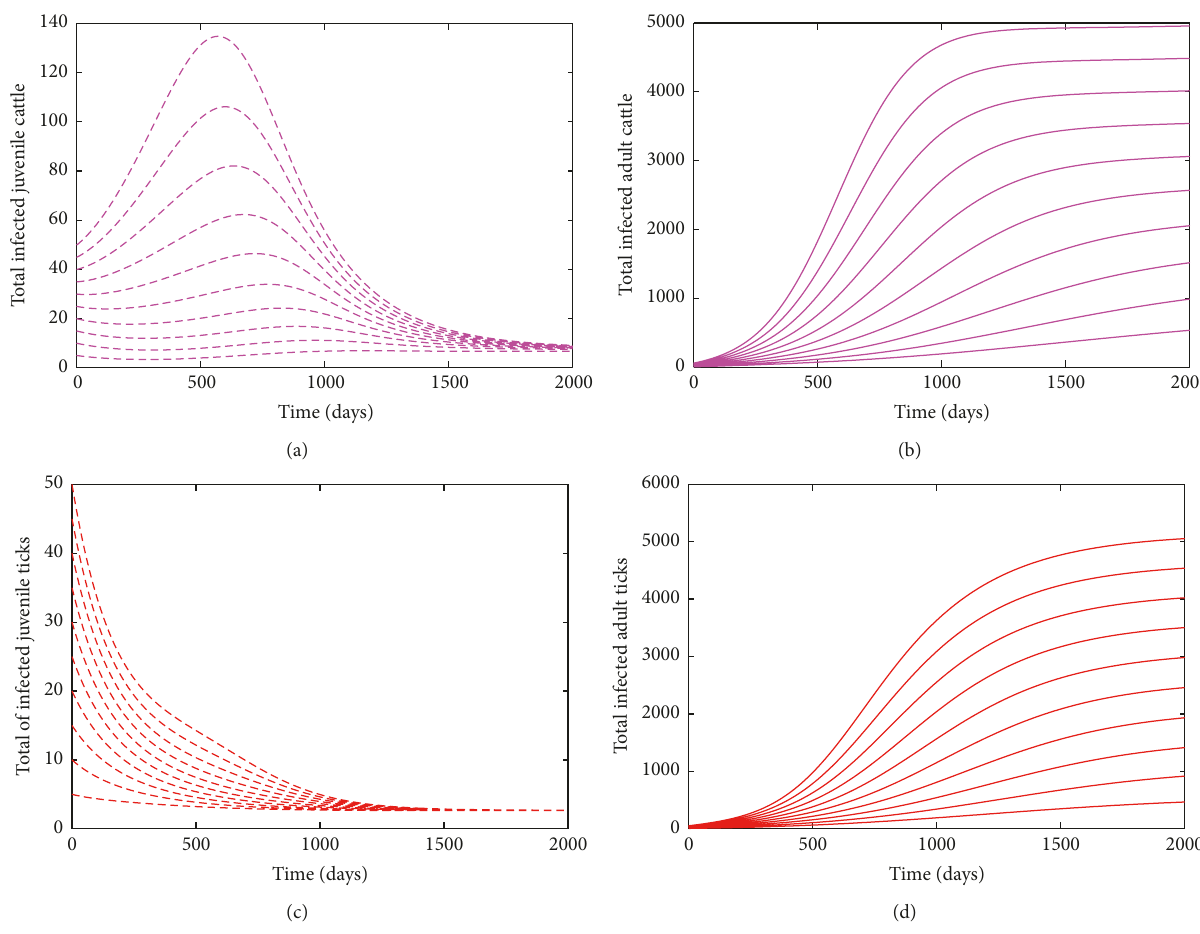
Figure 3: Simulation of the bovine anaplasmosis model (12) for different initial conditions as a function of time when R 0 > 1 . The different initial conditions converges to the endemic equilibrium when R 0 > 1 . (a) Total number of infected (asymptomatic, and carrier) juvenile cattle. (b) Total number of infected (asymptomatic, symptomatic, and carrier) adult cattle (c) Total number of infected juvenile ticks. (d) Total number of infected adult ticks. Parameter values used are as given in Table